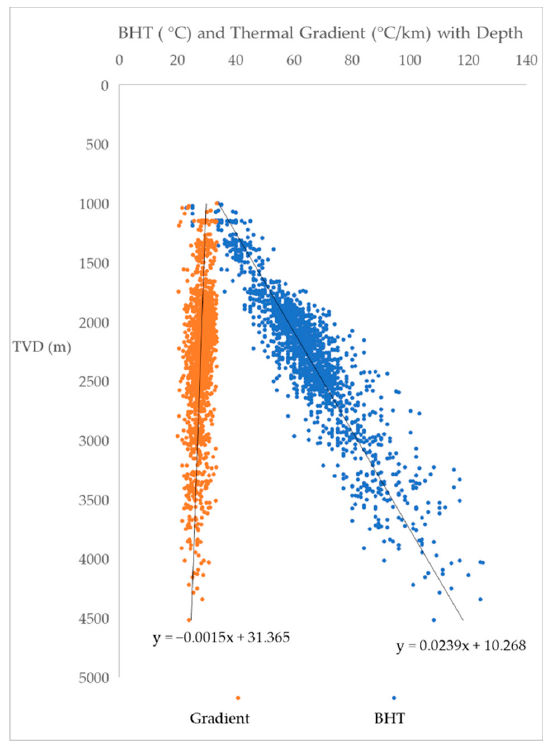
Figure 4. The calculated thermal gradient with depth of each well is shown as orange points. The BHT with depth of each well is shown as blue